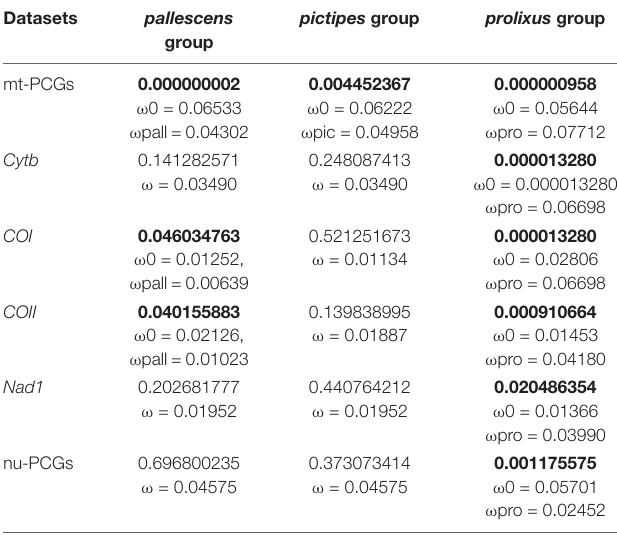
TABLE 4 | Test of selection results using the PAML